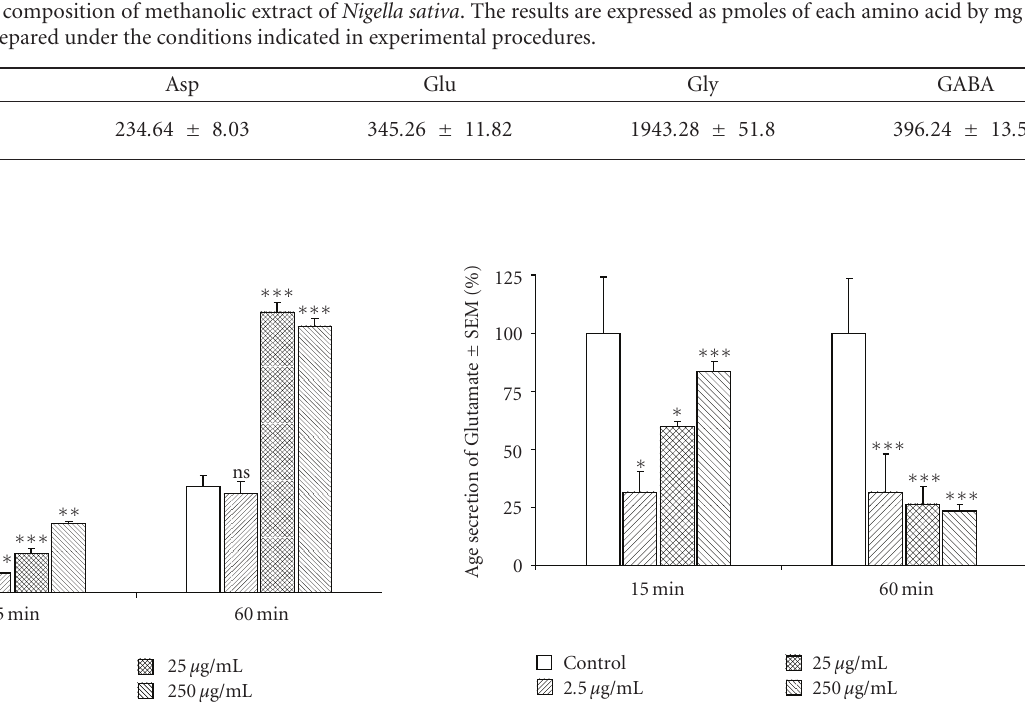
Figure 4: E ff ect produced by di ff erent concentrations (2.5, 25, and 250 μ g/mL) of methanolic extract of Nigella sativa on Glutamate release from cortical neurons. The cells were stimulated for 15 and 60 minutes with each concentration. The values are expressed as a percentage of secretion with respect to basal value (100%). Statis- tical significances were evaluated with respect to the corresponding control at its respective time points: ∗ P < . 05 and ∗∗∗ P < . 001.